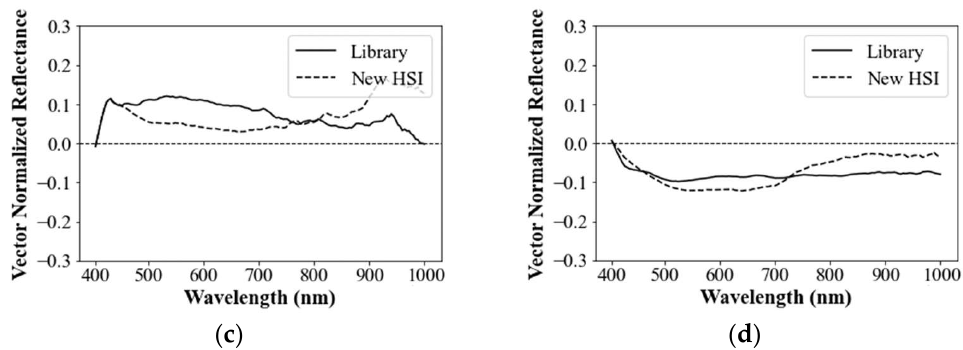
Figure 7. Exemplified comparison of the spectral spectrum between the spectral library and the HSI (Hyperspectral Image). ( a ) Hydrogen fluoride; ( b ) bromine; ( c ) phosphorus oxychloride; ( d ) ammo- nium bifluoride.